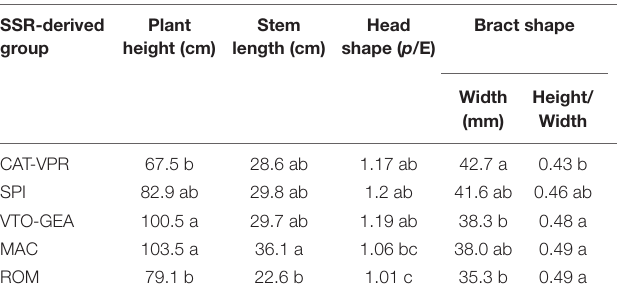
TABLE 6 | Differences between SSR-derived groups for plant height, stem length, and head and bract shape. SSR-derived